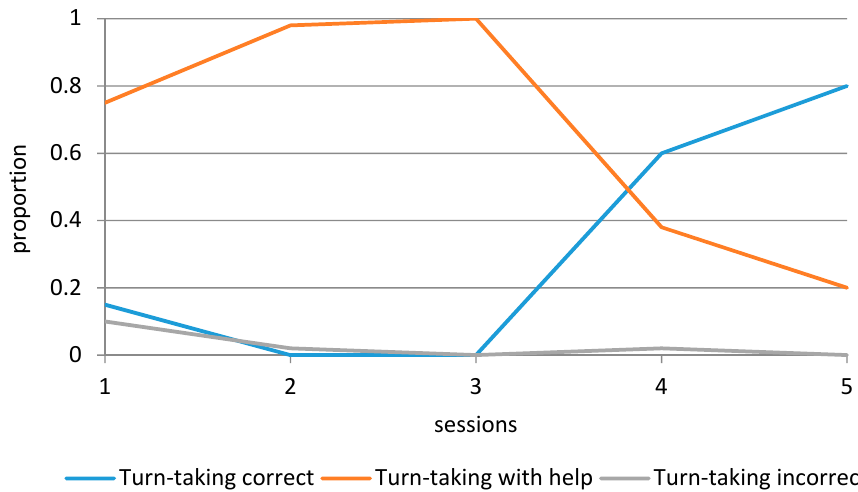
Figure 1. Graphical display of the participant’s verbal communication and tension over time.